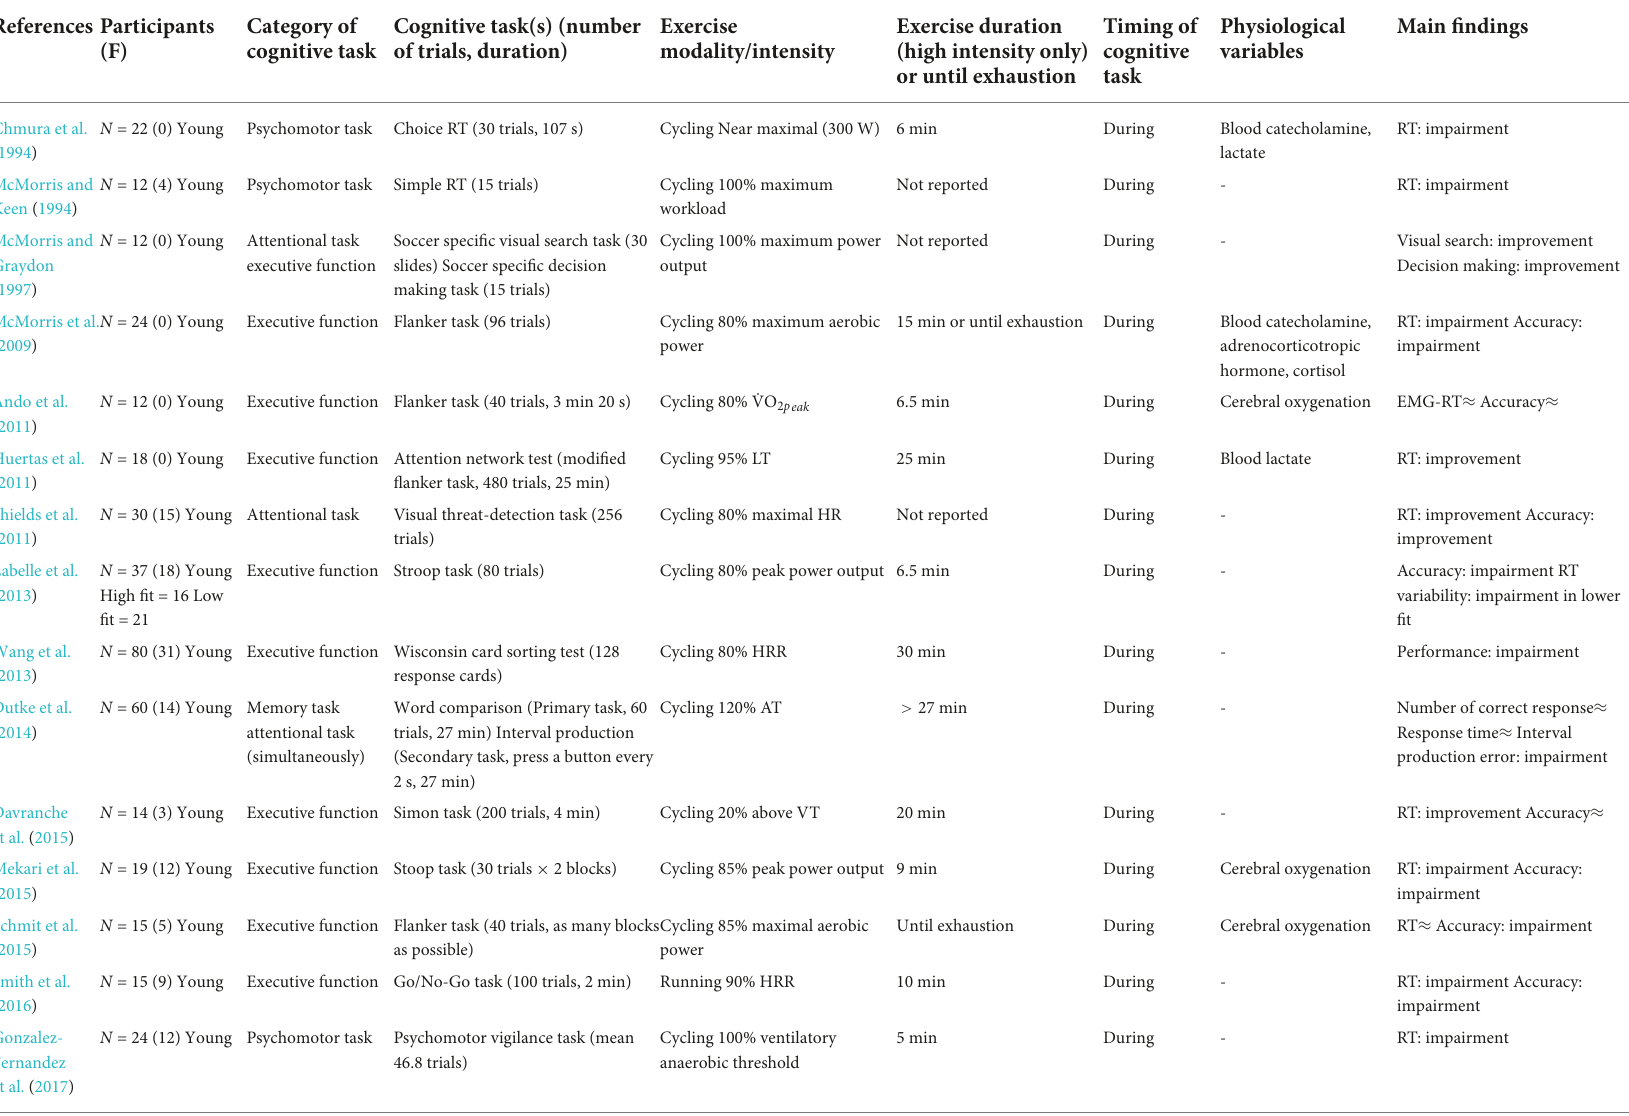
TABLE 1 Summary of the